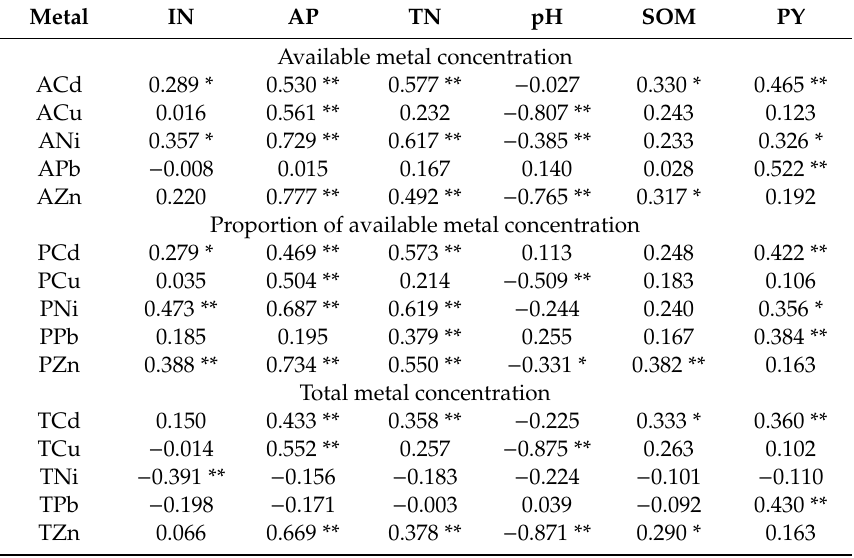
Figure 2. The properties of soil from the sampling sites: ( a ) inorganic N (IN); ( b ) available P (AP); ( c ) total N (TN); ( d ) pH; ( e ) organic matter (SOM); ( f ) planting year (PY). Table 2. Pearson’s correlation coe ffi cients between metals and soil IN, AP, TN, OM, PY, and pH. Metal